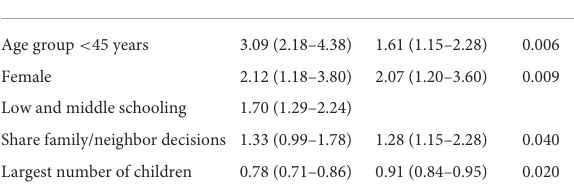
TABLE 3 Associations between “Control” CVH ( > 5 metrics at the ideal level) by search variables ( n =